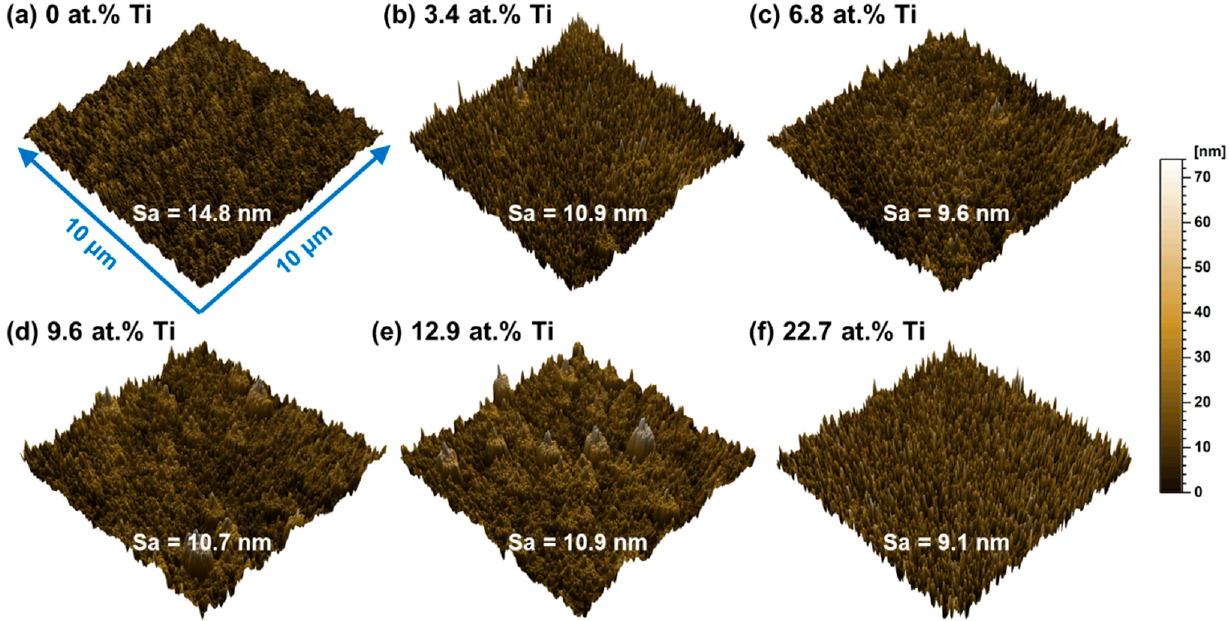
Figure 4. Surface AFM images and roughness of the WTi alloys films as a function of Ti concentra- tions.